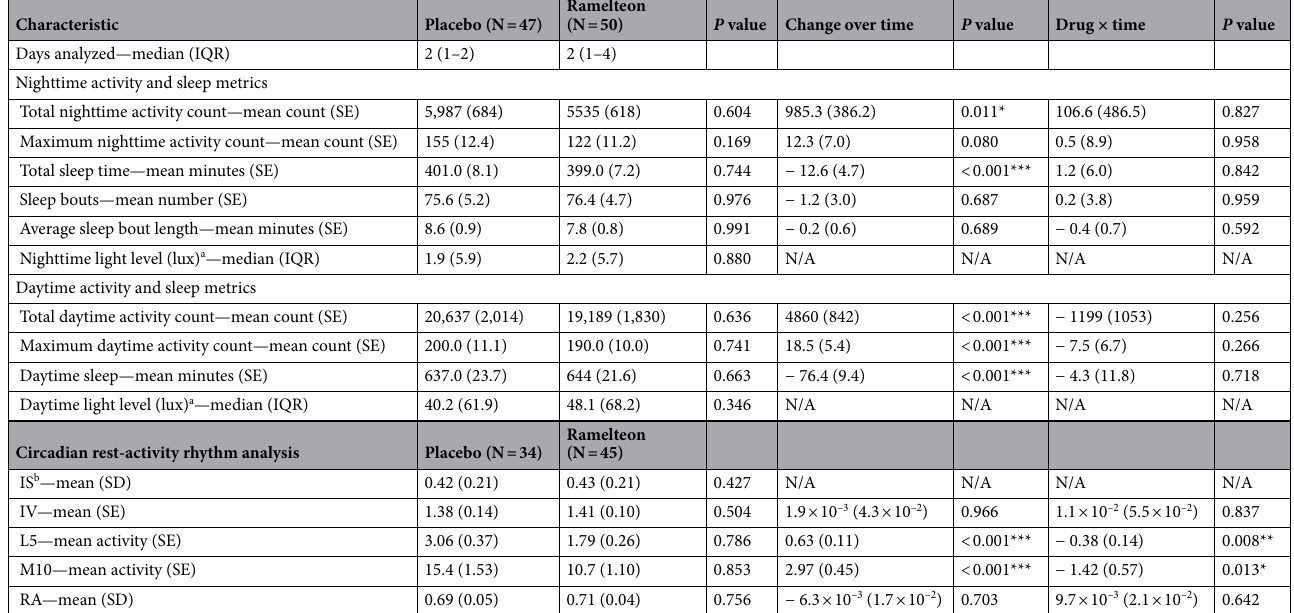
Table 2. Actigraphy data in patients receiving placebo vs. ramelteon. a Nighttime and daytime light levels between groups were compared using Mann–Whitney test. b Interdaily stability was compared using linear regression while all other metrics were compared using linear mixed effects